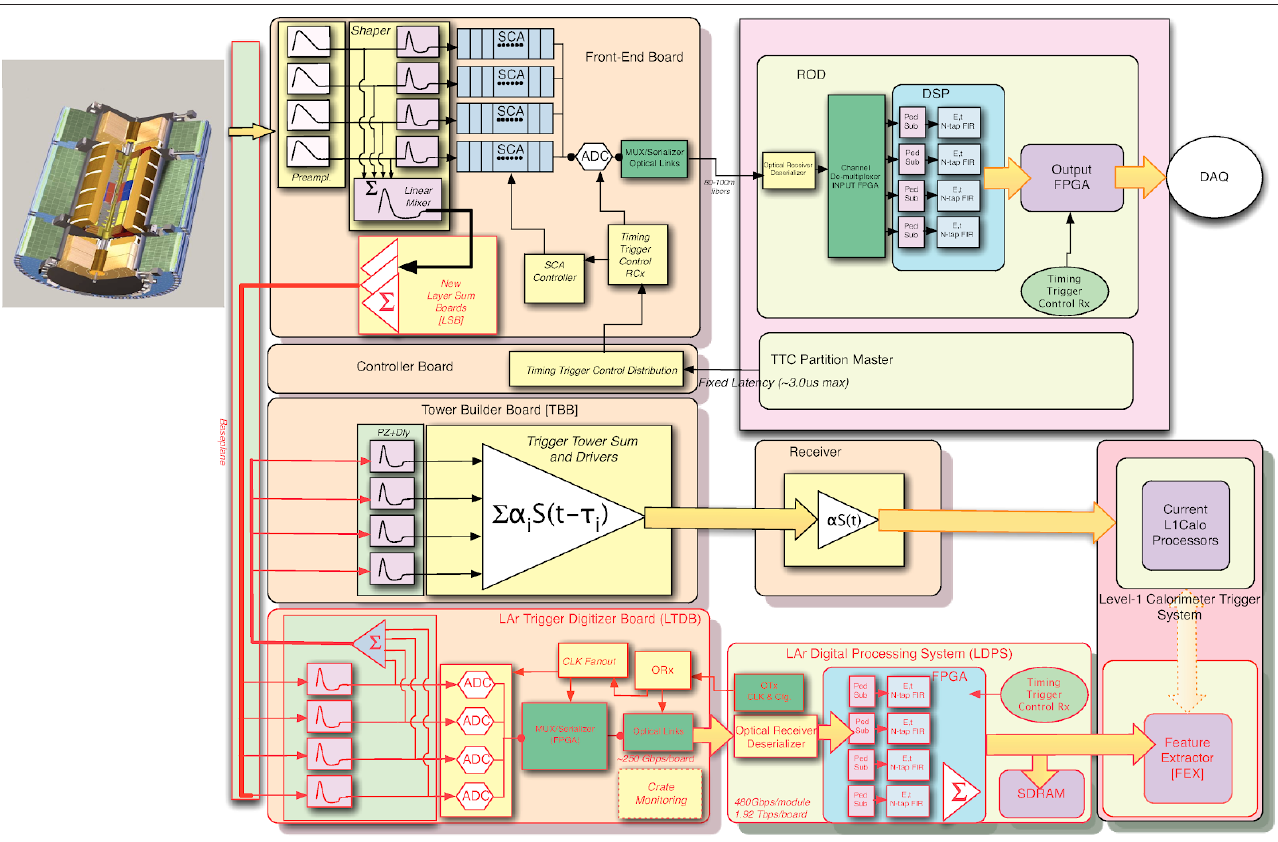
Figure 5: Schematic of the Phase-I upgrade architecture [7]. The new components are indicated by the red outlines and arrows. The main readout path (from FEBs to DAQ) and legacy trigger path (from FEBs to L1 via TBB) are also shown.